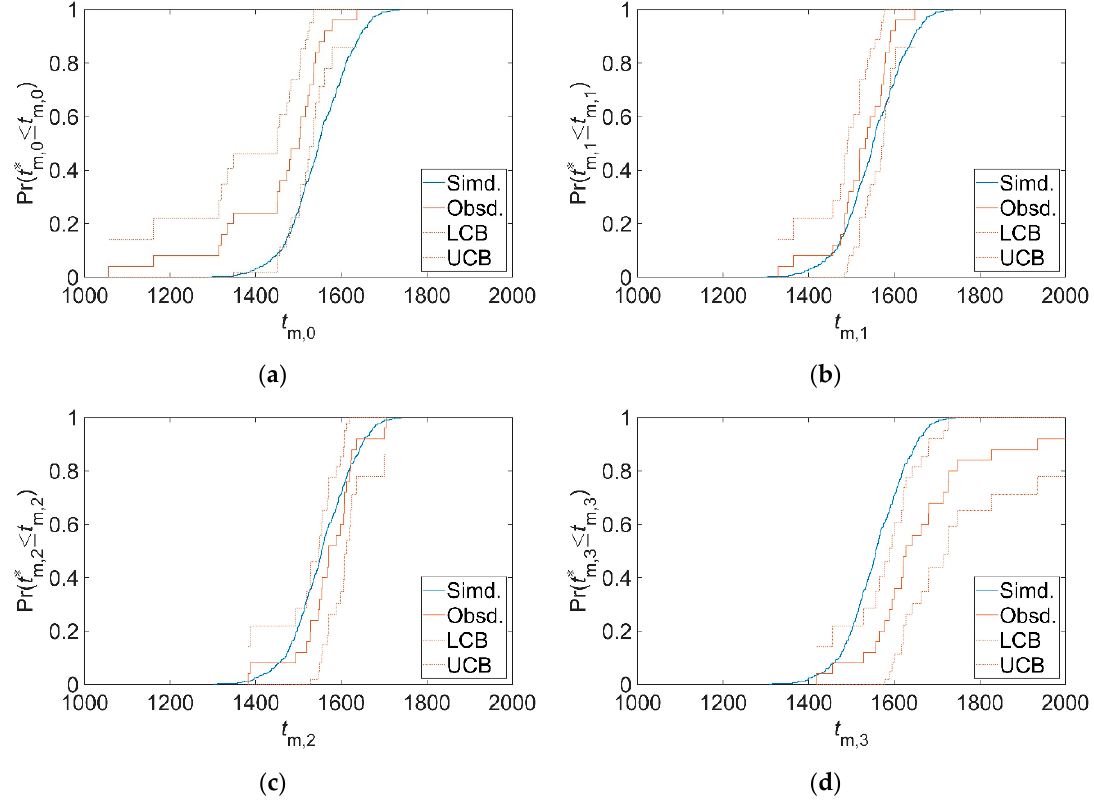
Figure 8. The simulated and observed cumulative distribution functions of the latent periods for the stochastic secondary nucleation: ( a ) at j’ = 0, ( b ) at j’ = 1, ( c ) at j’ = 2, and ( d ) at j’ = 3. LCB: lower confidence bound and UCB: upper confidence bound.